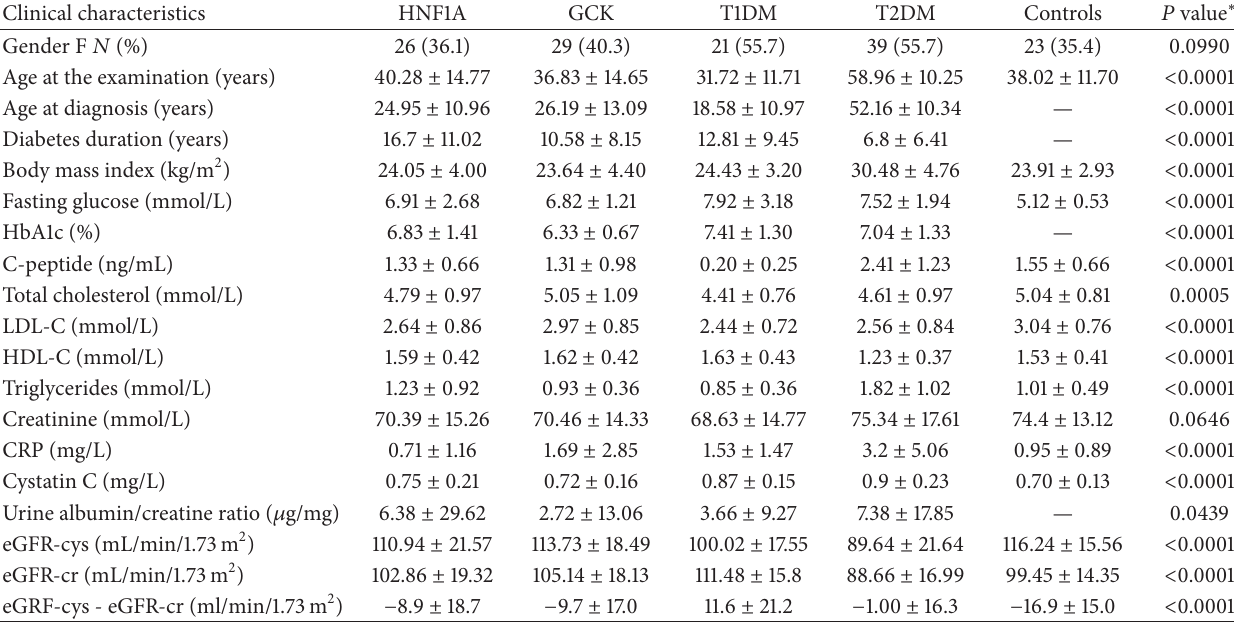
Table 1: Clinical characteristics of patients and controls without